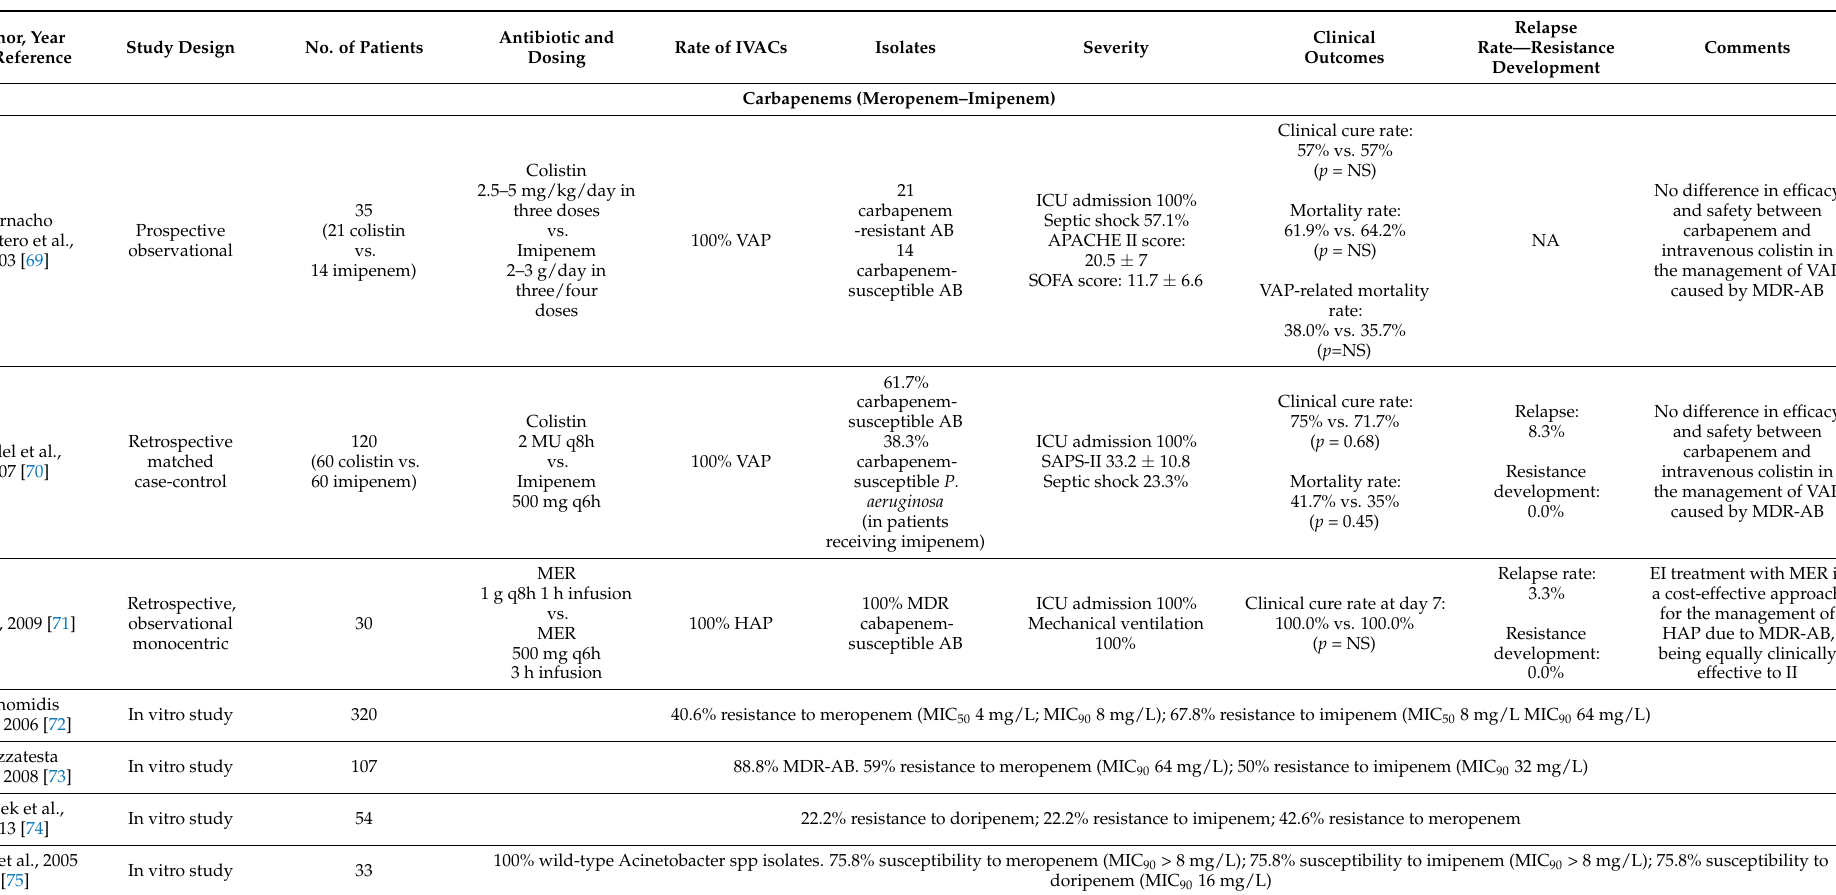
Table 5. Summary of the studies investigating the treatment of carbapenem-susceptible Acinetobacter baumannii infection-related ventilator-associated complications (IVACs) with